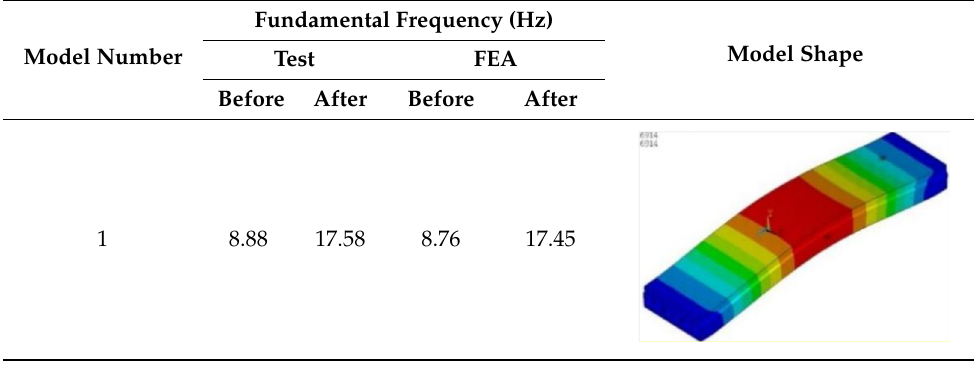
Table 3. Fundamental frequency results.